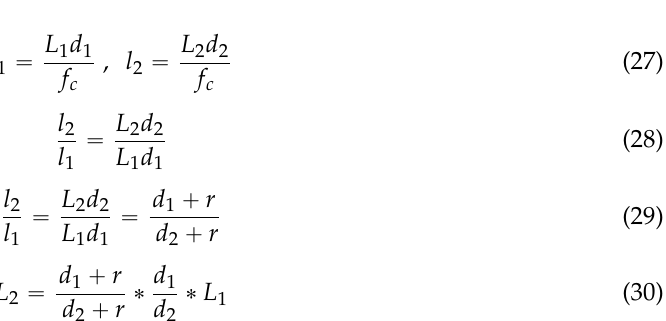
Figure 6. Camera perspective model.